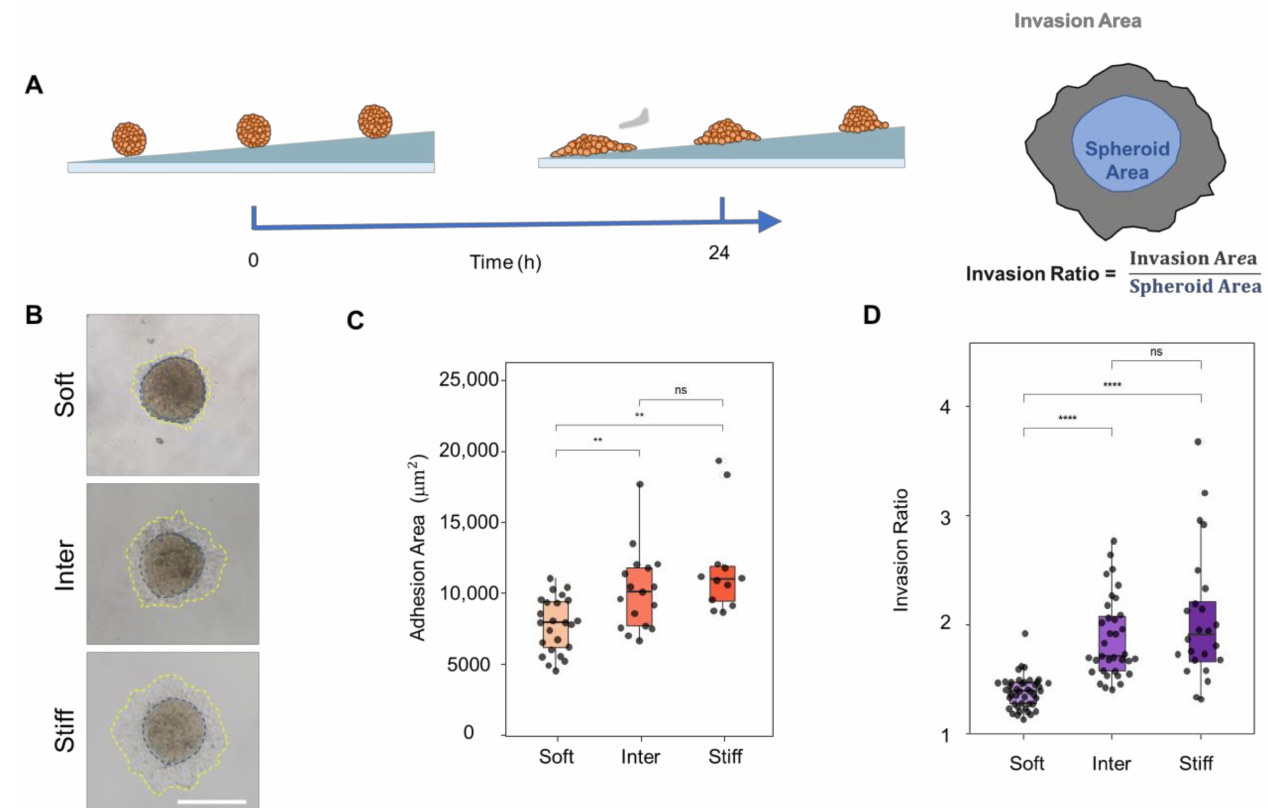
Figure 5. Stiff simulated ECM enhances the adhesion and invasion of multicellular JAR spheroids. ( A ) ( Left ): schematic diagram of JAR spheroid invasion assay. ( Right ): schematic diagram of the calculation of the invasion ratio. ( B ) Image of JAR spheroid invasion taken by an inverted microscope (scale bar: 200 µ m). ( C ) Calculated adhesion area of JAR spheroids on different regions. ** p < 0.01, n = 24, 17, 12 for Soft, Inter, and Stiff, respectively. Data reported as mean ± standard deviation for N = 3 independent experiments. Each scatter indicated each spheroid being measured. ( D ) Calculated invasion ratio of JAR spheroids on different regions. **** p < 1 × 10 − 6 , n = 43, 35, 25 for Soft, Inter, and Stiff, respectively. Data reported as mean ± standard deviation for N = 3 independent experiments. Each scatter indicated each spheroid being